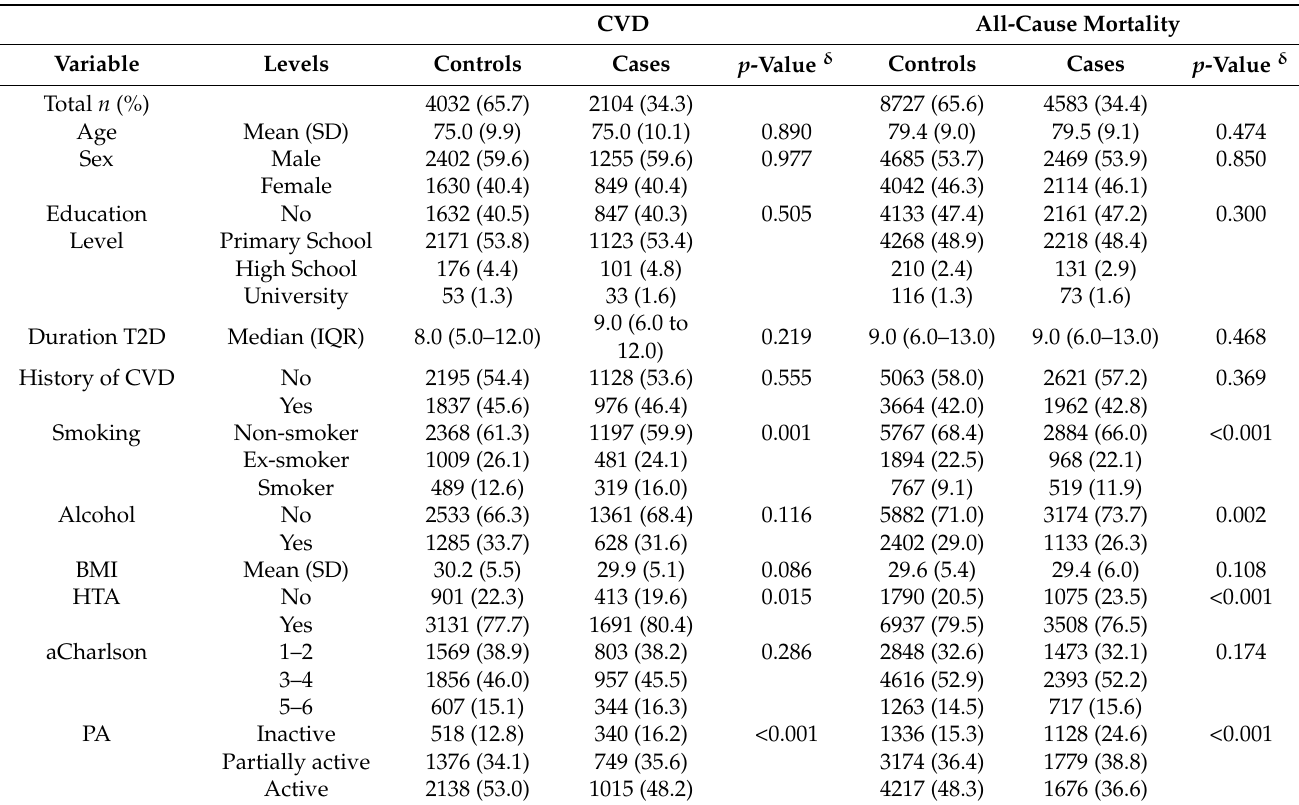
Table 3. Characteristics of the CVD group and the control group included in nested case–control study from the total cohort of subjects with Type 2 diabetes. CVD All-Cause Mortality